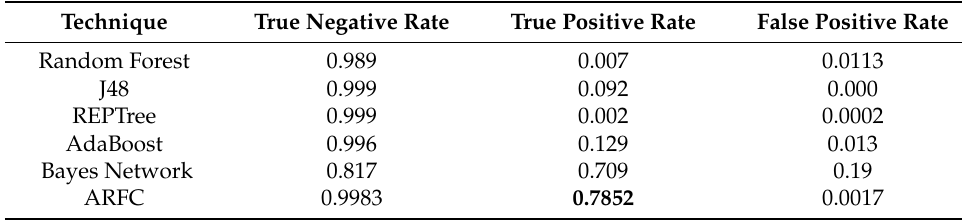
Table 3. Comparison of the accuracy between ARFC and five batch classifiers.